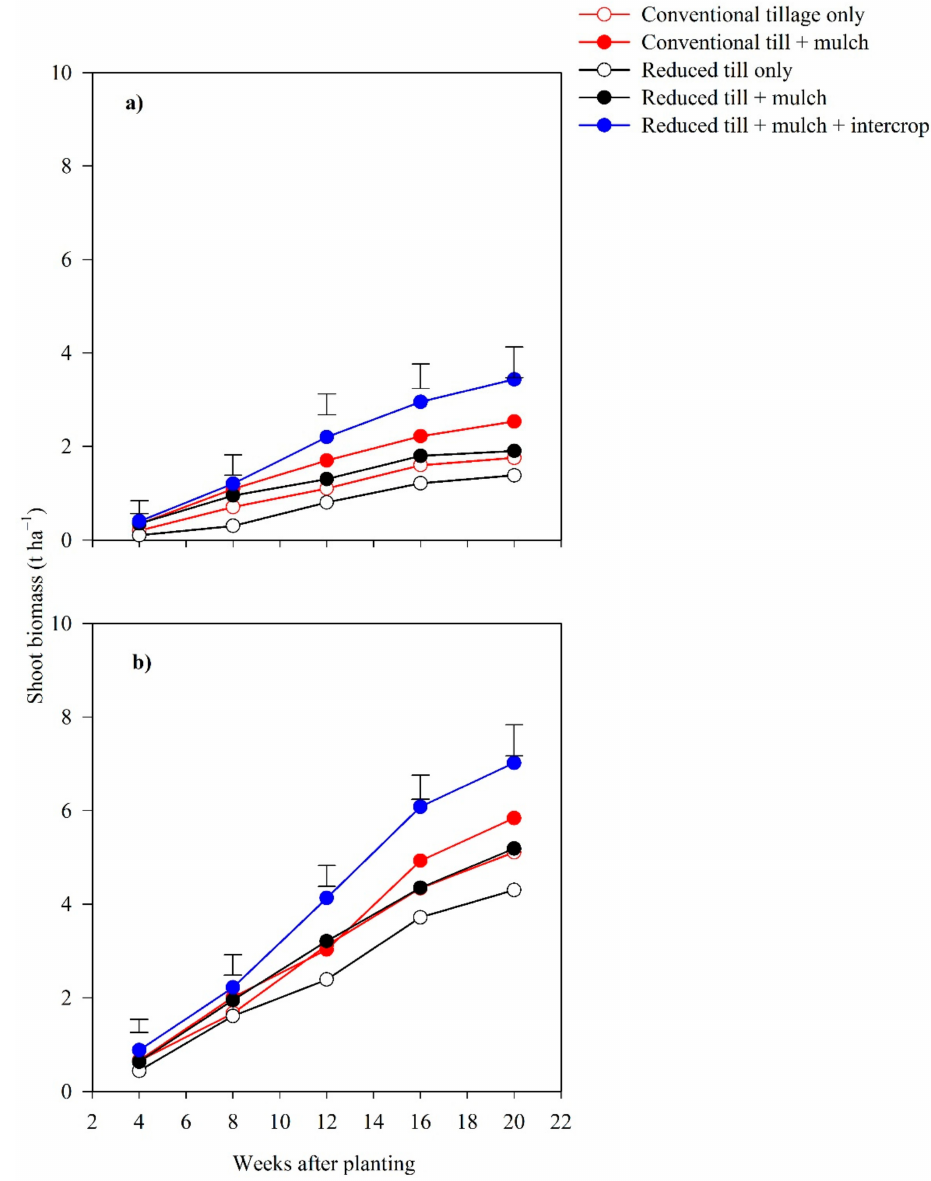
Figure 4. Development of finger millet shoot dry biomass with conventional tillage only (control), conventional tillage + mulch (partial CA1), reduced tillage only (partial CA2), reduced tillage + mulch (partial CA3) and reduced tillage + mulch + intercropping with cowpea (full CA) treatments during 2015/16 ( a ) and 2016/17 ( b ) cropping